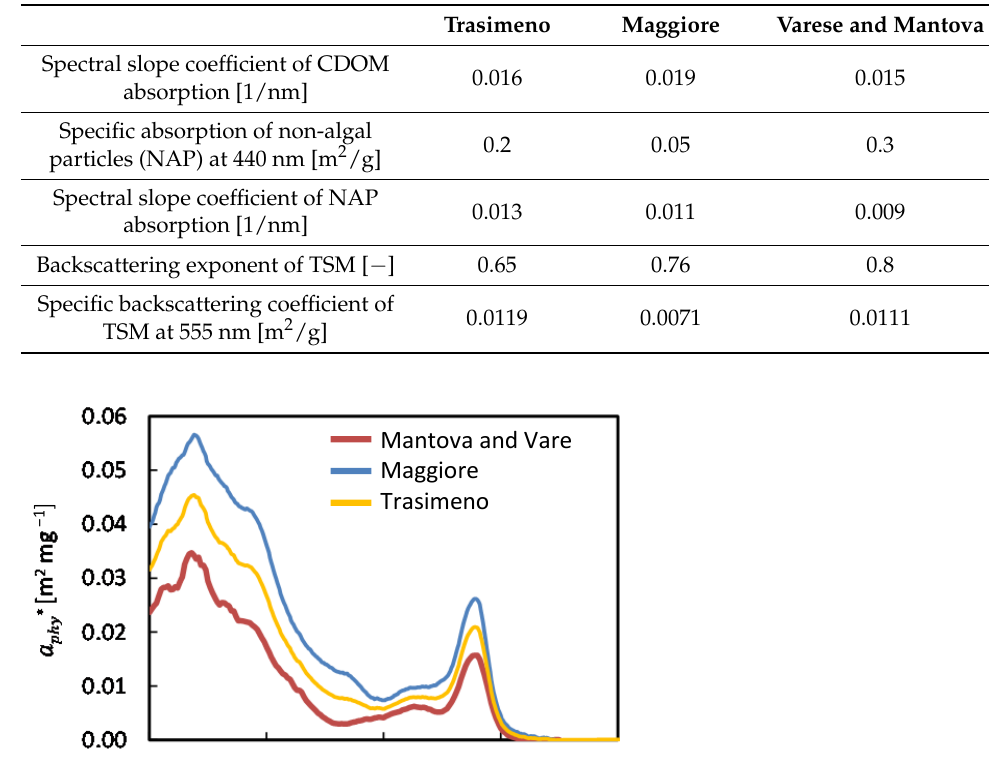
Table 2. Site-specific inherent optical properties (IOPs) of Italian lakes used for parametrizing BOMBER.